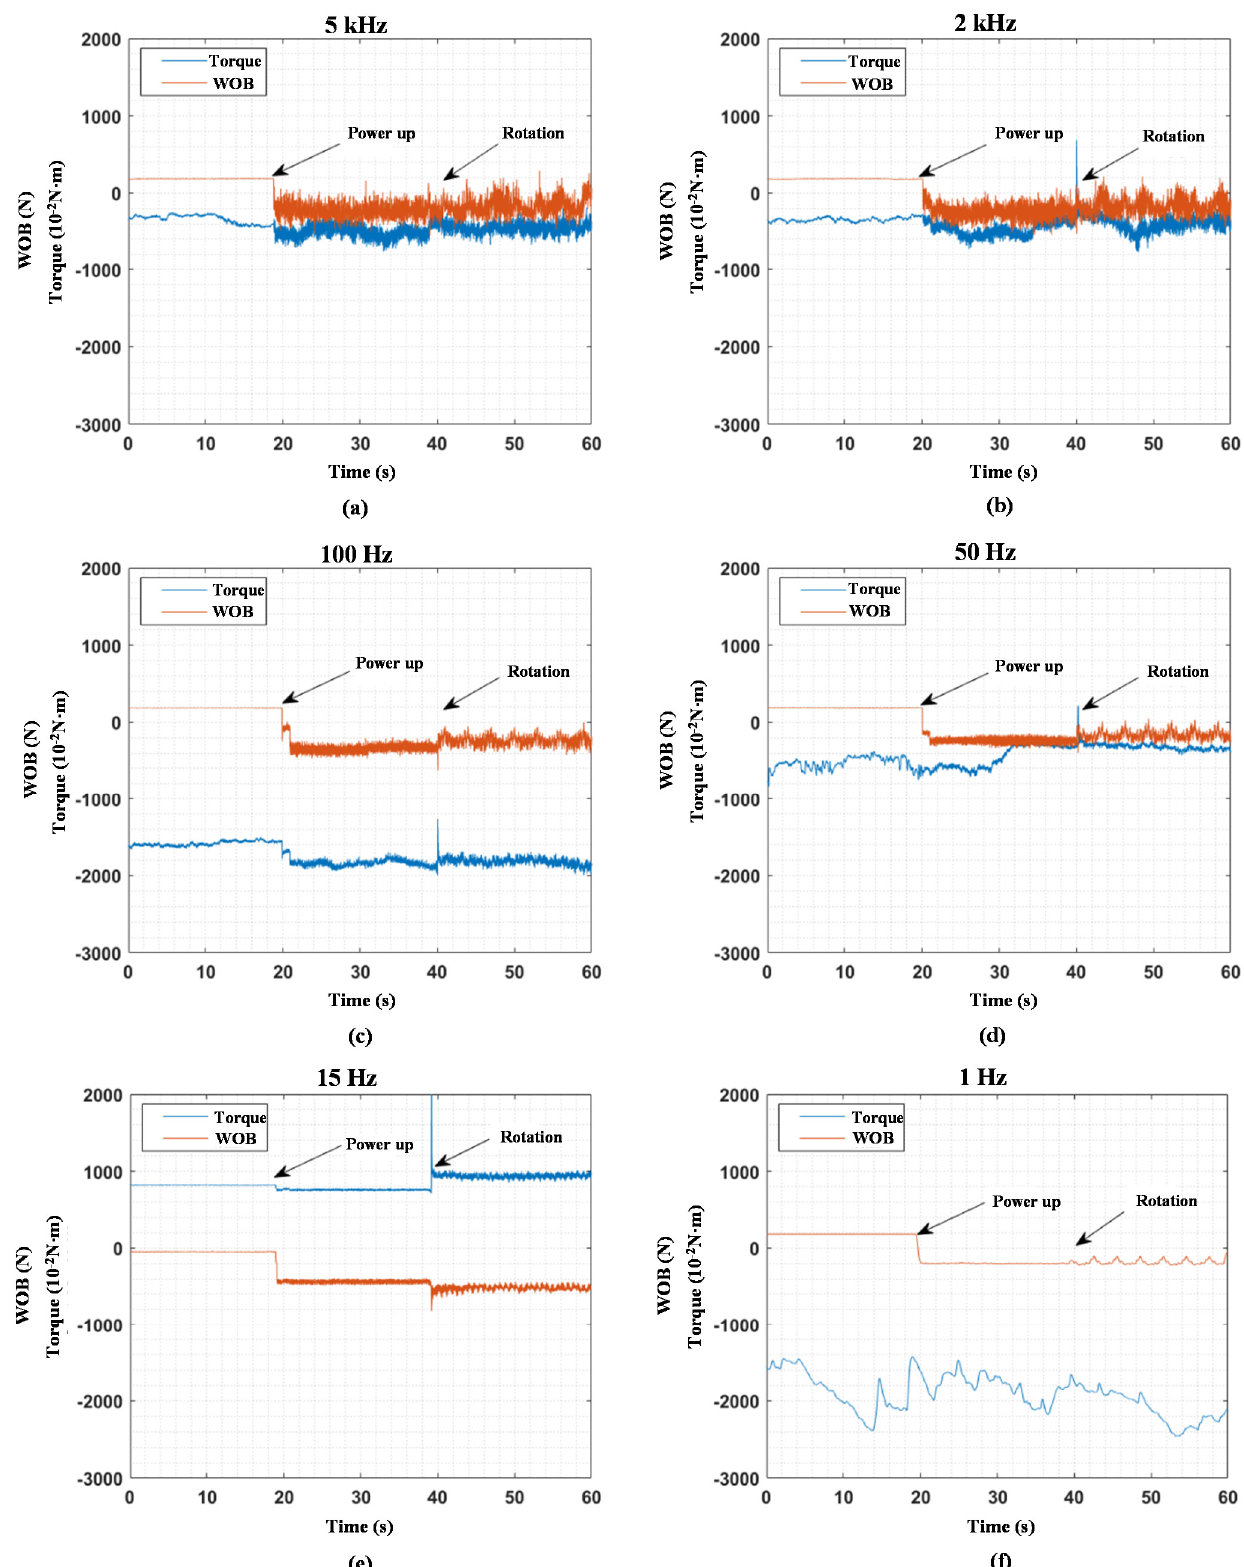
Figure 7. Signal diagram of low-pass filtering at different frequencies. ( a – f ) are signal diagrams at frequencies of 5 kHz, 2 kHz, 100 Hz, 50 Hz, 15 Hz and 1 Hz. The arrows from figure indicate change of the state.